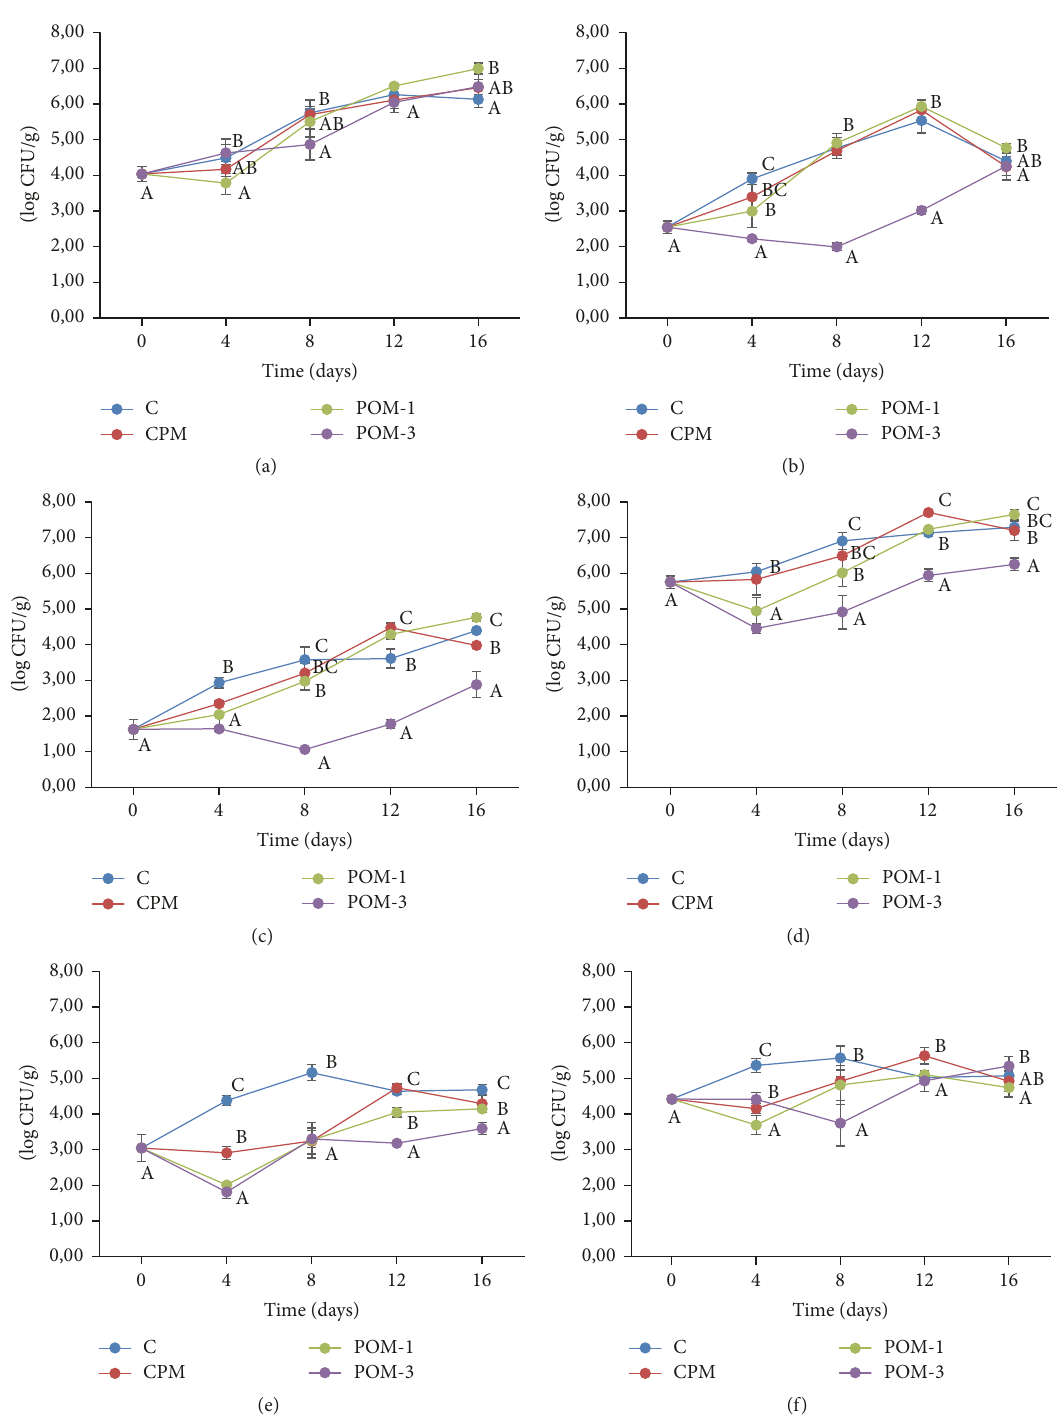
Figure 3: Evolution of the natural microbiota of WPI-Or coated hake fillets stored under MAP conditions. C: control; CPM: control-WPI; POM-1:WPI+Or 1%;POM-3:WPI-Or3%. (a)Totalviable counts; (b)lacticacid bacteria; (c) Enterobacteriaceae